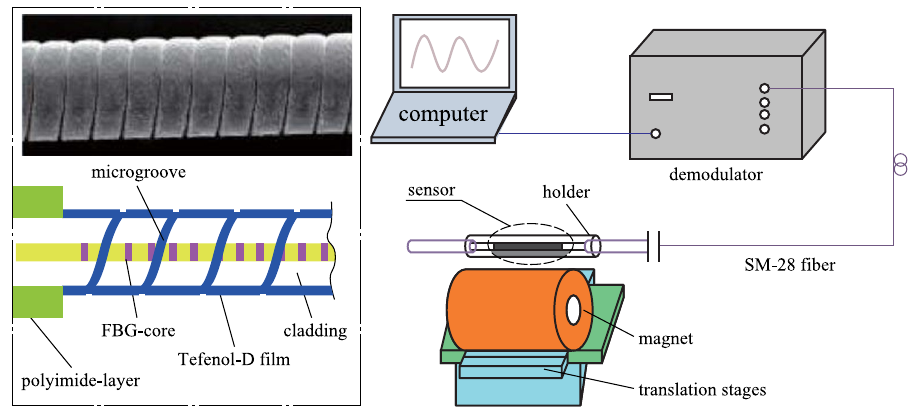
Fig. 2 Sputter fiber Bragg grating (FBG) sensor structure [14]. Copyright 2013, Dai Y. Reproduction with